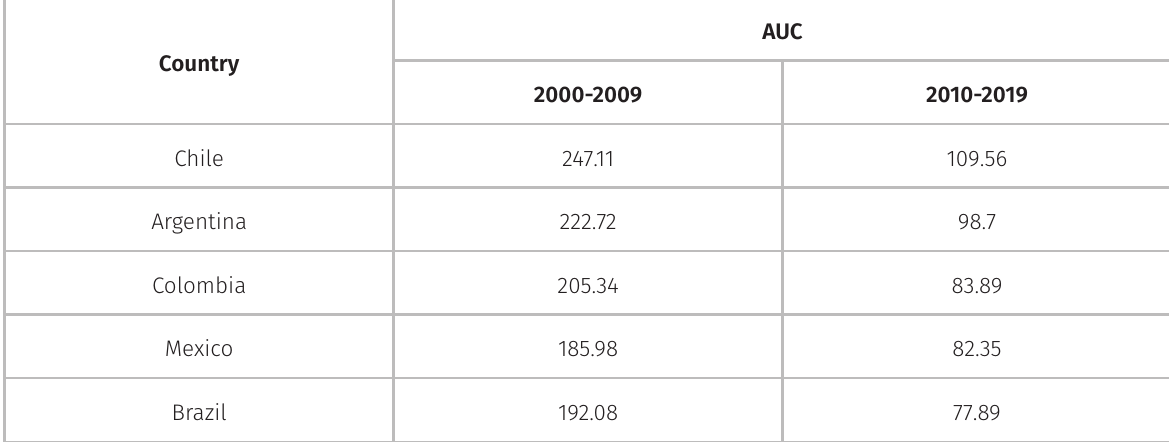
Table I. Area Under the Curve (AUC) for the number of citations per document against time (year) in the five Latin American countries publishing more scientific journal articles. AUC was calculated before the implementation of QUALIS (years 2000-2009) and after (years